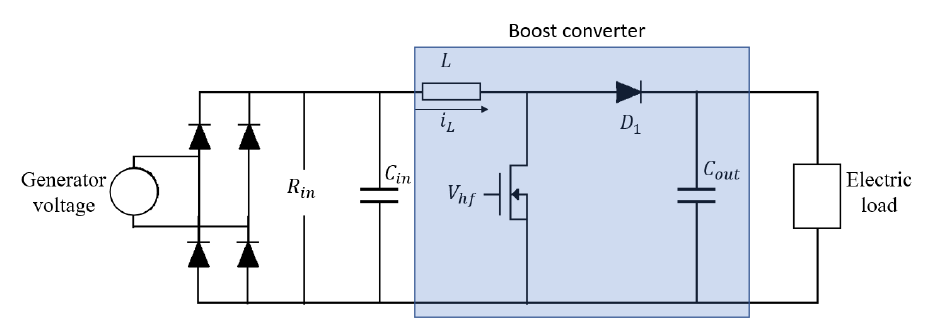
Figure 11. Boost converter as a resistor